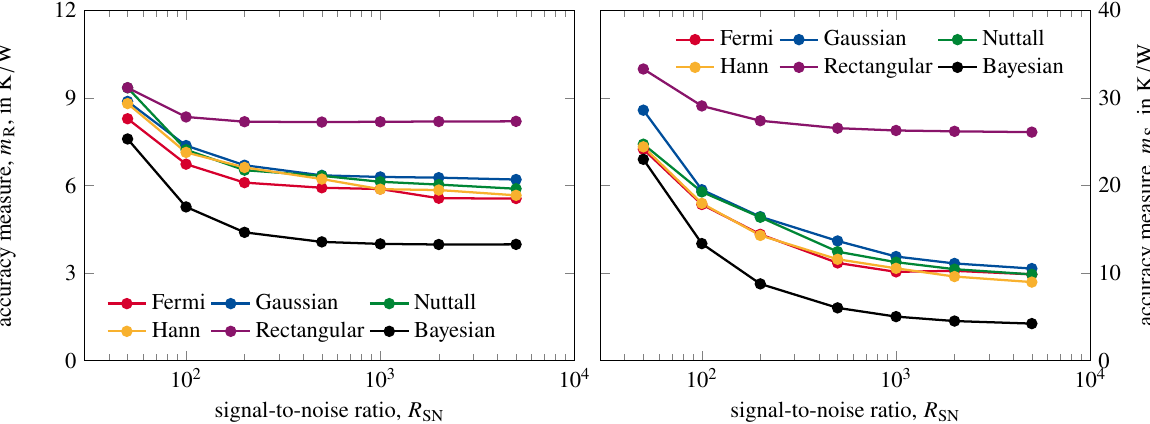
Figure 6. Accuracy of the median integrated time constant spectrum and median structure function, calculated via Fourier and Bayesian deconvolution as a function of the signal-to-noise ratio from 2000 noise